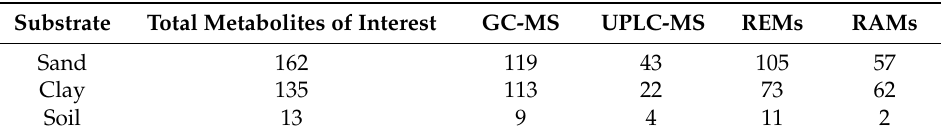
Figure 3. Principal component analysis (PCA) scores plot for principle components ( a ) 1 and 3 and ( b ) 2 and 4. Data from GC- and UPLC-MS analyses were combined, and the analysis is based on 1304 metabolites. No-plant controls are represented by half-shaded symbols, genotype BTx623 by open symbols, and genotype SC56 by closed symbols. Circles represent the sand substrate, squares the clay substrate, and triangles the soil substrate. Table 1. Number of metabolites of interest detected within each substrate. Metabolites of interest were determined after adjusting p-values for false discovery rate and using p < 0.05 and a log 2 fold change of >1 (REMs) or <-1 (RAMs).